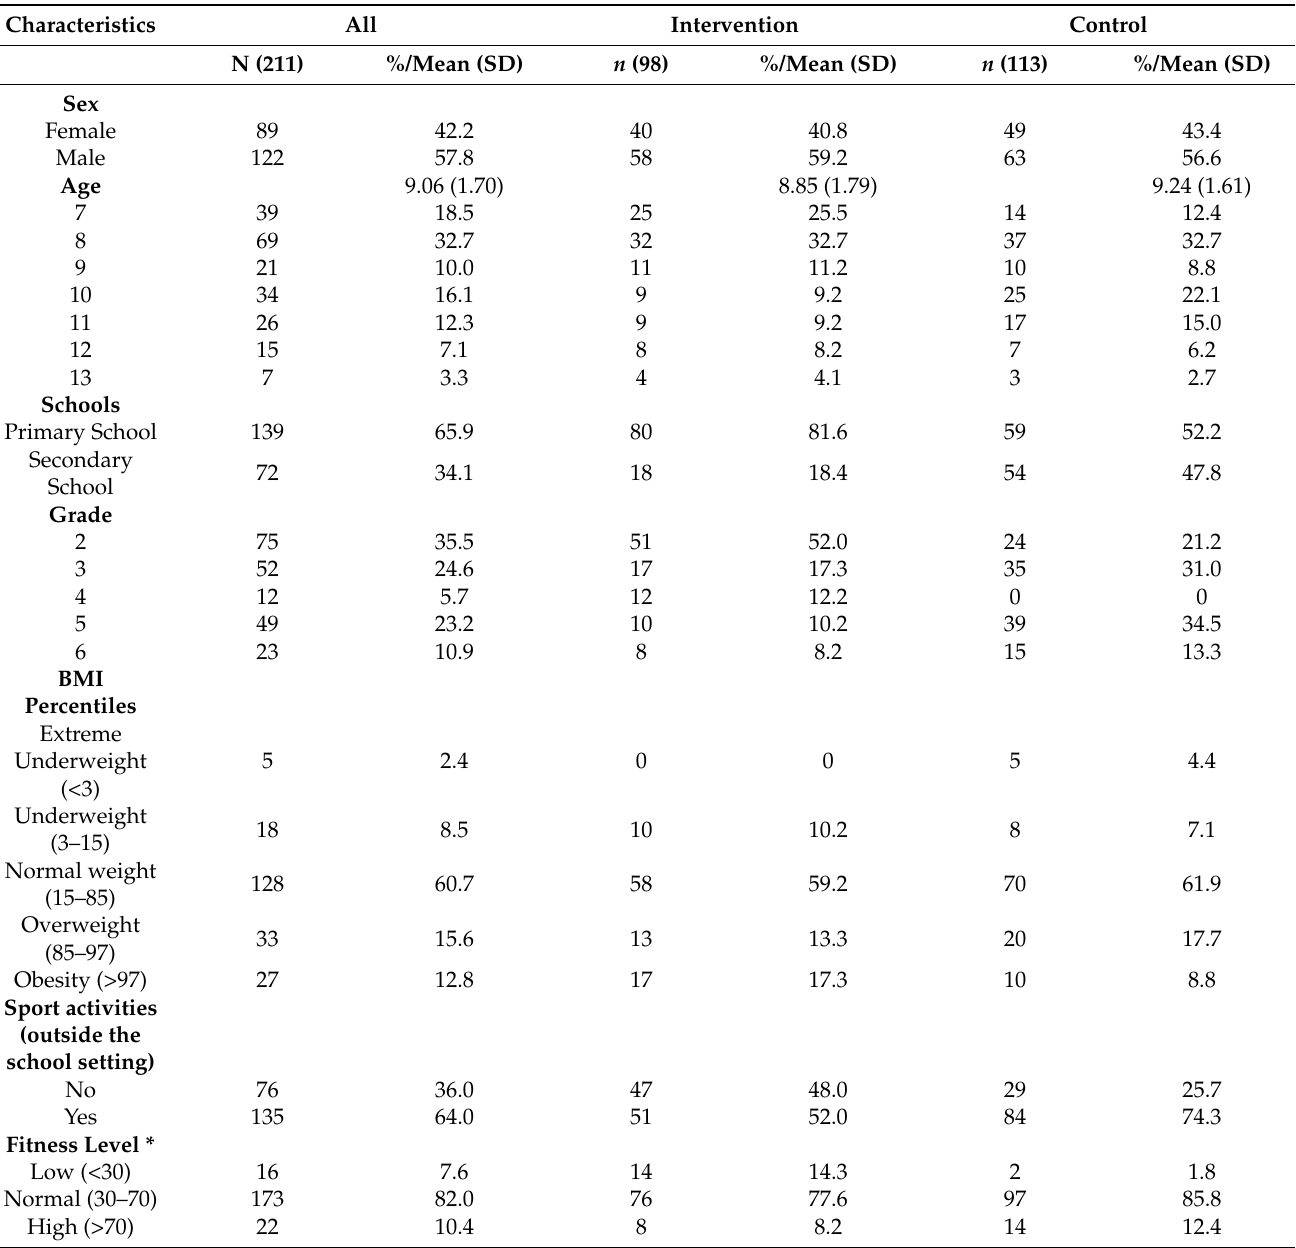
Table 2. Descriptive characteristics of overall and intervention and control group